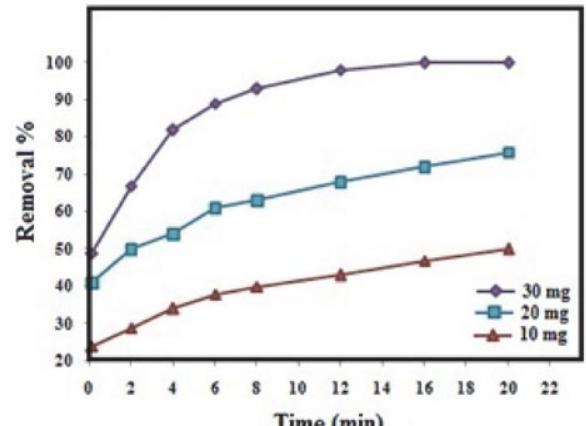
Figure 11. The effect of with different dosages of GO/Co removal of MB